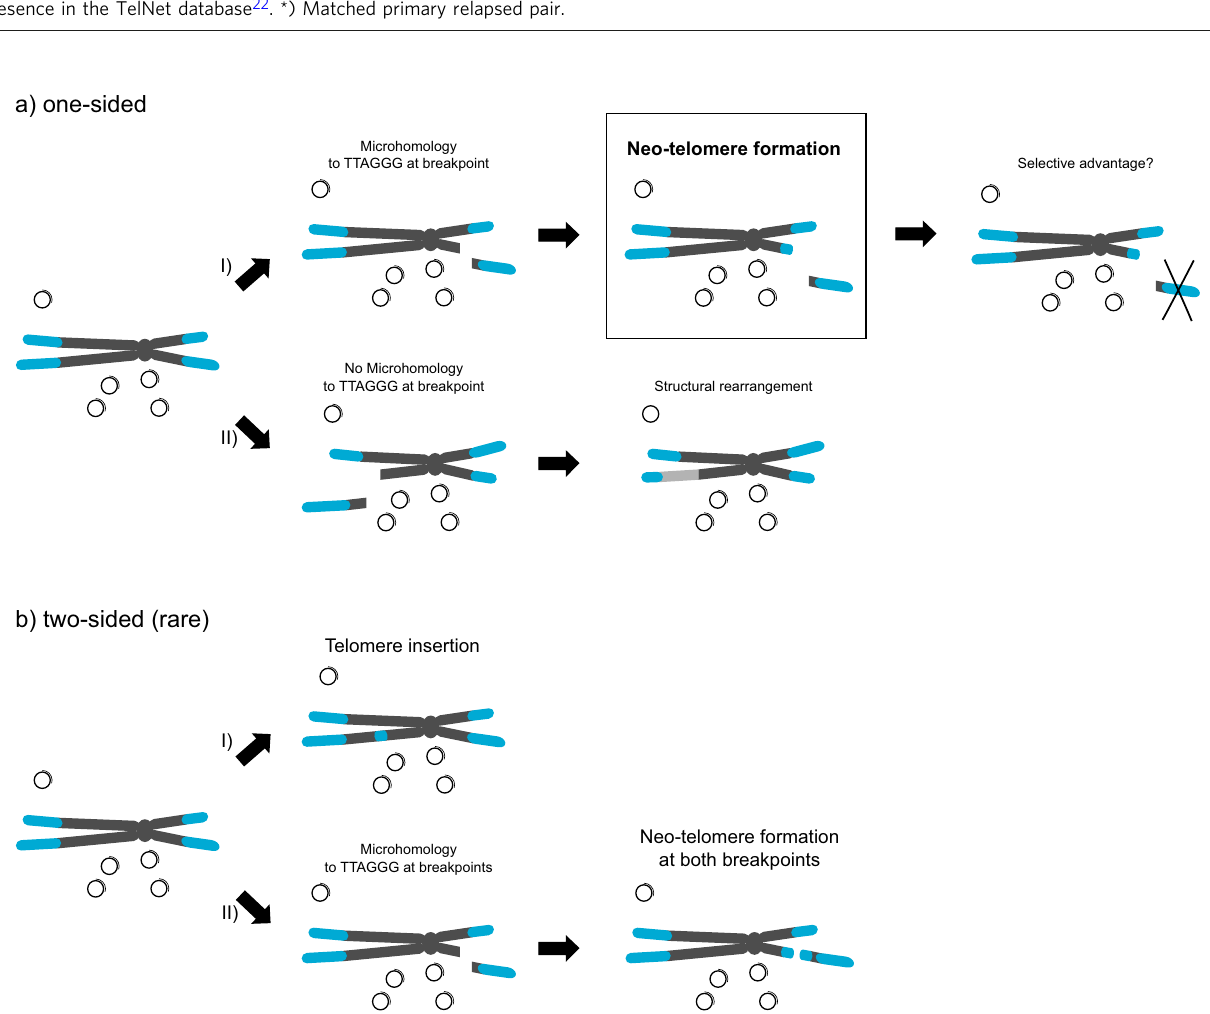
Fig. 8 Model of neo-telomere formation. Graphical abstract illustrating the hypothesis of neo-telomere formation in ALT-positive neuroblastomas. a The majority of telomeric repeat loci are one-sided. We hypothesize that ALT-positive cells are able to add telomeric sequences to open chromosomal breaks to protect them from degradation. I Microhomology to TTAGGG favors the formation of a neo-telomere at the open chromosomal break. Loss of some chromosomal regions might present a selection advantage for the cell and cells with a neo-telomere at the chromosomal breakpoint are selected. II Without microhomology, structural rearrangements involving other chromosomal arms (light gray) can represent an alternative route of protecting open chromosomal breaks. b Rare two-sided events can result from insertion of telomeric sequences I or from the formation of neo-telomeres on both sides of the breakpoint II . Small circles represent C-Circles. Chromosomes are shown in gray and telomeric sequences in Methods proteome analysis ( n = 34), and ChIP-sequencing ( n = 27) was done for subsets of Patient cohorts and tumor samples . We retrospectively analyzed cohorts of the discovery cohort. A summary of the clinical information and available data for every patient in the discovery cohort is given in Supplementary Data 3. Patients primary and relapsed neuroblastoma tumors. ALT-activity was determined using were enrolled in the neuroblastoma clinical trials (NB2004-HR/NCT03042429, C-Circle assays for 720 neuroblastoma tumors (screening cohort, Supplementary Data 1). High coverage whole genome sequencing (WGS) data was obtained for a subset of 165 tumors (discovery cohort). RNA-sequencing ( n = 144), whole